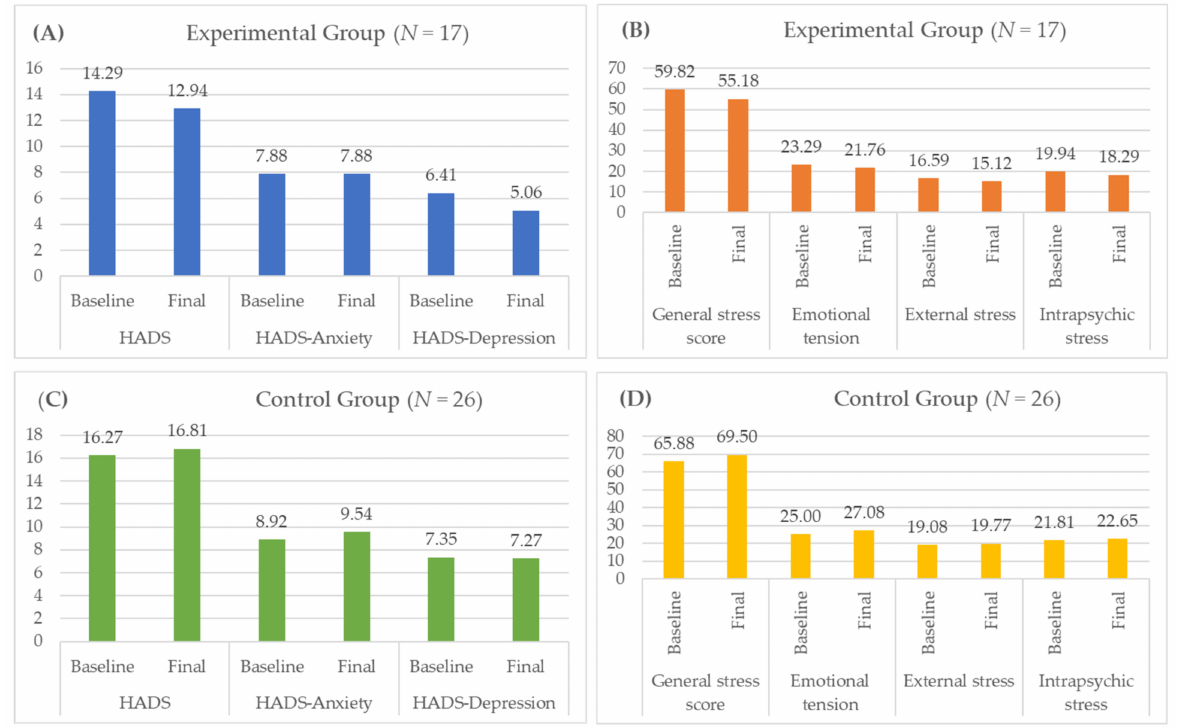
Figure 1. Mean values in the baseline and final measurement for Hospital Anxiety and Depression Scale (HADS) and stress level for Experimental ( A , B ) and Control ( C , D )